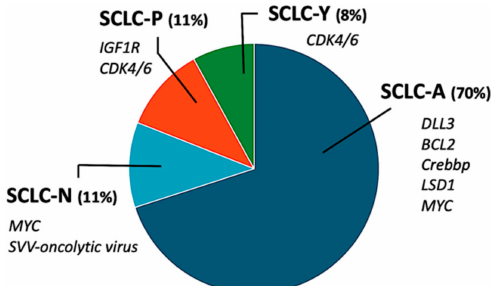
Figure 1. Proposed nomenclature describing small cell lung cancer (SCLC) molecular